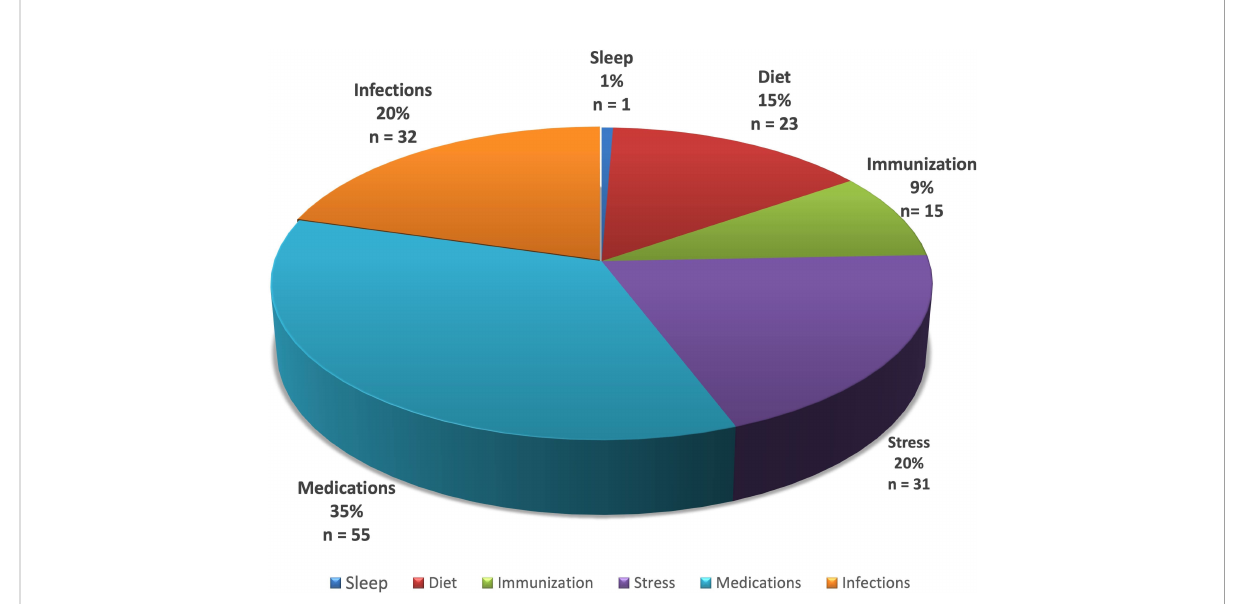
FIGURE 1 Distribution of literature results after screening for PV induction or exacerbation as linked to speci fi c lifestyle/environmental factors. Subgroups identi fi ed are represented as a percentage (%) and number (n) of all studies meeting